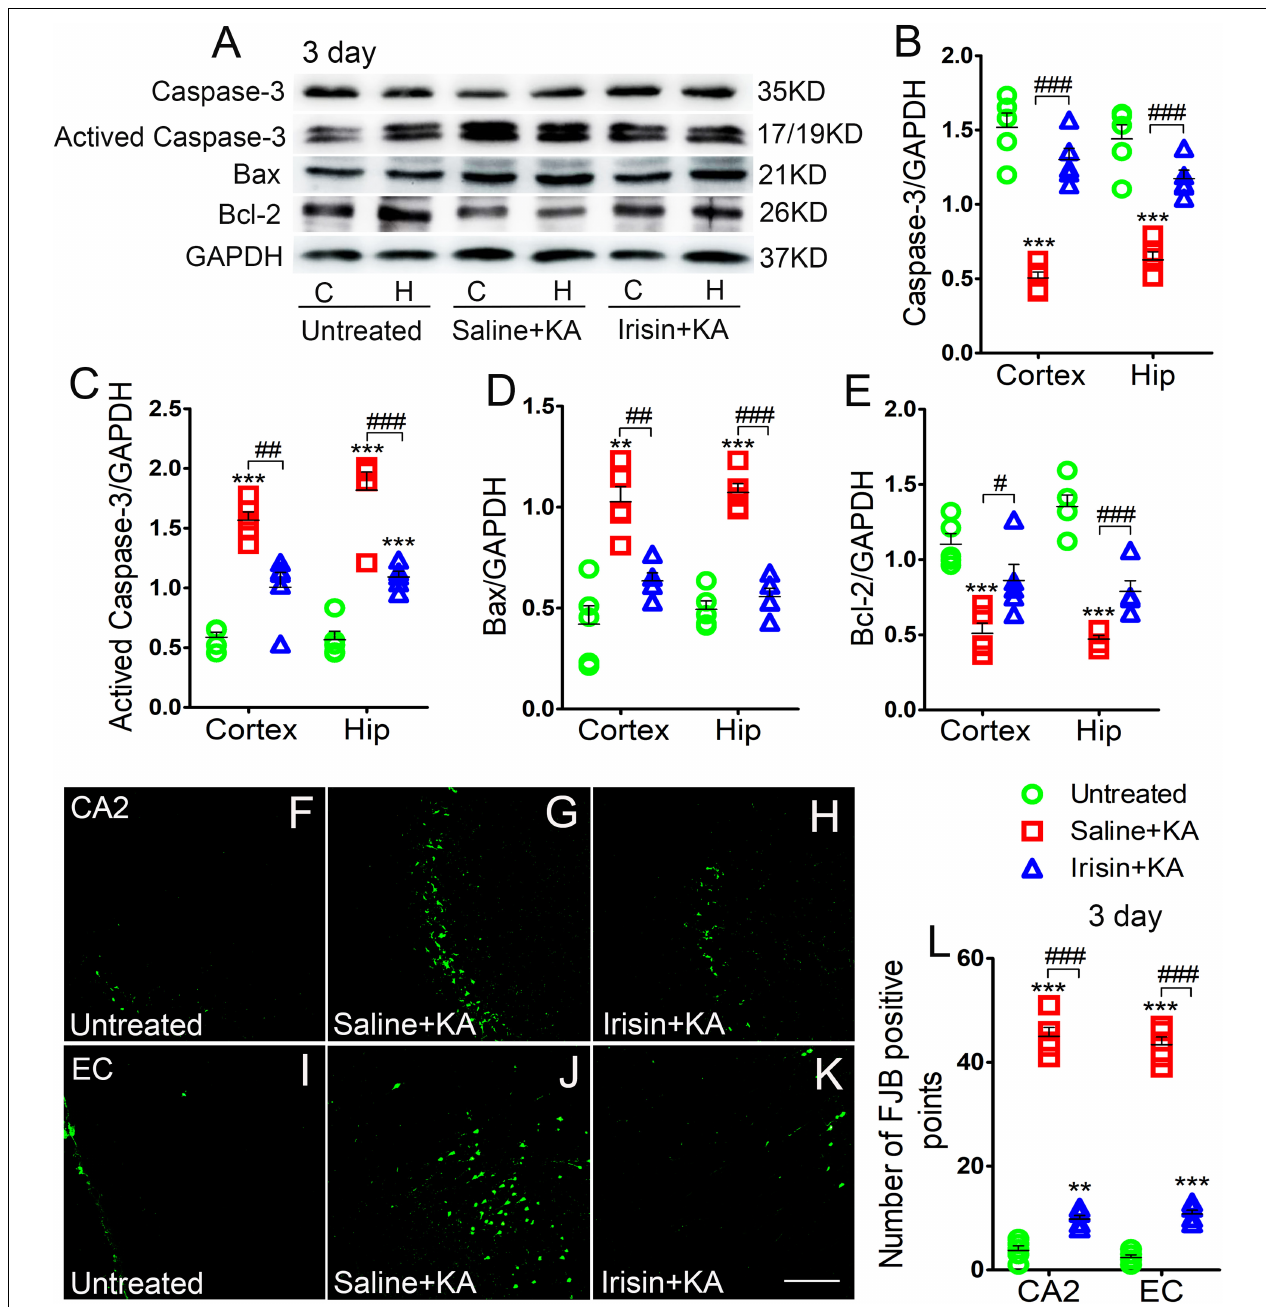
FIGURE 2 | Exogenous irisin treatment alleviated apoptosis and neuronal injury in rats with KA-induced SE. (A) The levels of caspase-3, activated caspase-3, Bax, and Bcl-2 in the cortex and hippocampus after irisin treatment ( n = 5/group). (B–E) Normalized intensity of caspase-3, activated caspase-3, Bax, and Bcl-2 relative to GAPDH. (F–L) Positive FJB signals in the CA2 and EC after irisin treatment ( n = 5/group, bar = 50 µ m). ** P < 0.01, *** P < 0.001, compared with controls; # P < 0.05, ## P < 0.01, and ### P < 0.001 compared with each other (One-way ANOVA with Dunnett’s T3 post hoc test). C, cortex; H/Hip, hippocampus; CA2, cornu ammonis 2; EC, entorhinal cortex; Bcl-2, B-cell lymphoma-2; Bax, Bcl-2-Associated X.